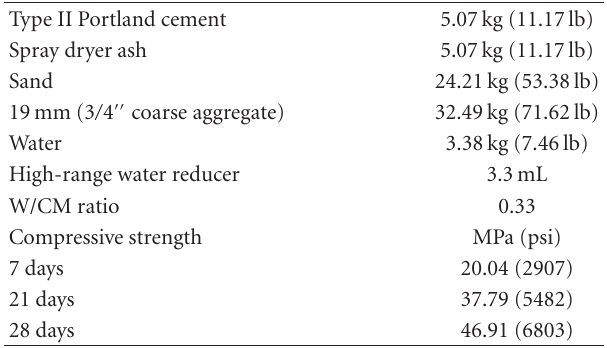
Table 4: SDA concrete mix Design weights for 0.093 cubic meter (1cubic foot) of 50% SDA concrete.